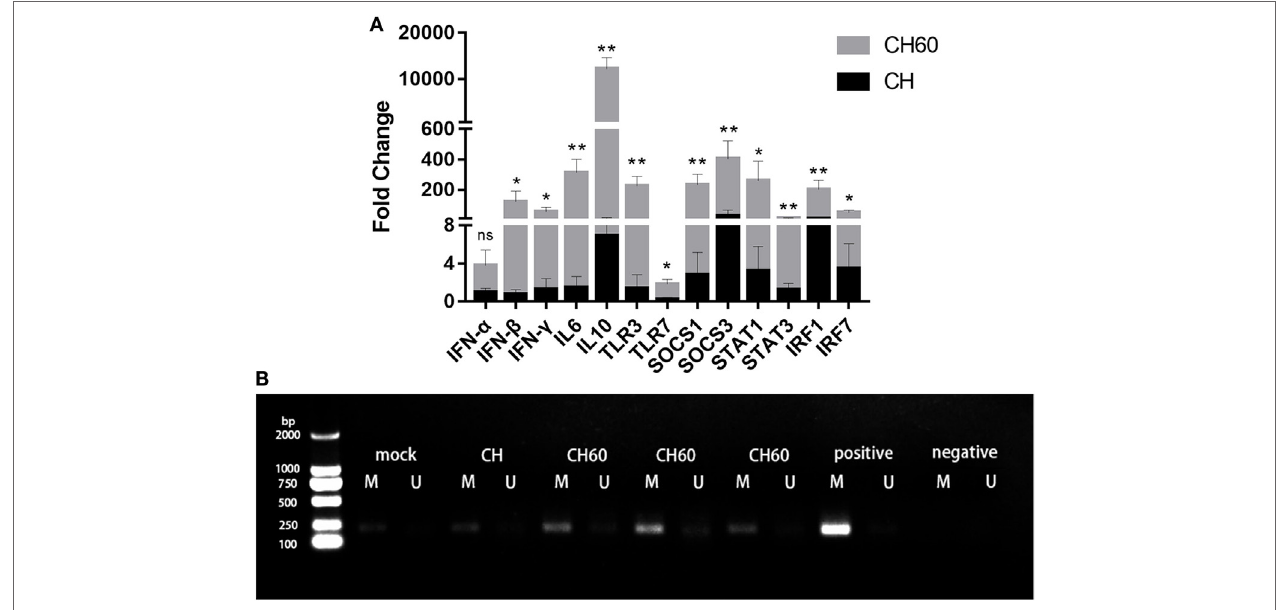
FigUre 7 | Confirmation of differentially expressed genes by RT-PCR and methylation status of SOCS3 . (a) Gene expression levels were measured by the 2 −ΔΔ Ct method with relative quantification. Differences in the expression levels of the various genes between strains CH and CH60 were analyzed using Student’s t -test and were considered significant as follows: * p < 0.05; ** p < 0.01; (B) Methylation status of the SOCS3 gene in liver tissues from Duck hepatitis A virus type 1 (DHAV-1)-infected embryonated eggs. DNA from the liver tissues of embryonated eggs infected with DHAV-1 at 48 hpi was subjected to methylation-specific PCR. M, methylation-specific primers; U, non-methylation-specific primers.